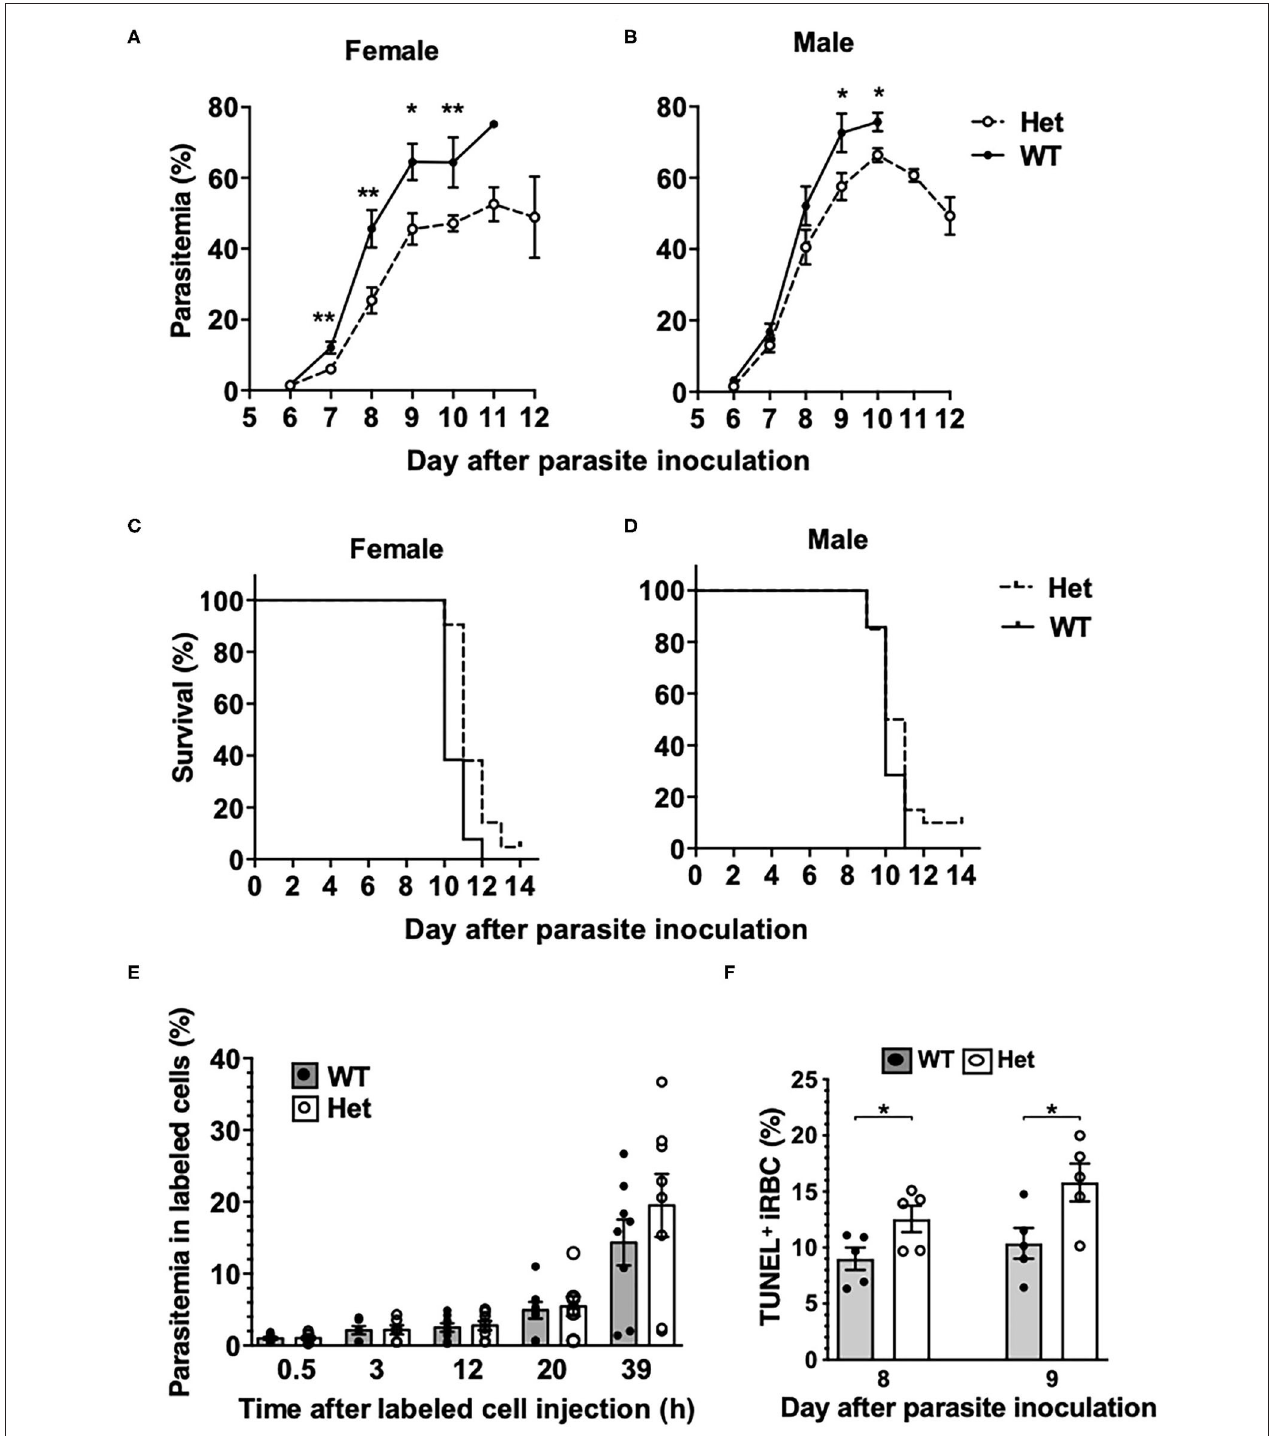
FIGURE 2 | Mice with the Pbgd MRI 58155 mutation display an increased resistance to infection with P. chabaudi . (A,B) Parasite growth and (C,D) survival in Pbgd MRI 58155 heterozygotes (Het) and wild-type littermates (WT) infected with P. chabaudi (1 × 10 4 parasites; 13–21 mice per group). (E) Parasitemia measured at various timepoints in labeled donor RBC following transfusion into P. chabaudi infected recipient mice (8 days after parasite inoculation). Donor RBC were from Pbgd MRI 58155 heterozygotes (Het) or wild-type littermates (WT) (8 recipient mice per group). (F) Proportions of TUNEL-labeled parasite-infected erythrocytes in Pbgd MRI 58155 heterozygotes (Het) or wild-type littermates (WT) infected with P. chabaudi (five per group). Error bars represent SEM. * p < 0.05, ** p < 0.01, calculated using a two-tailed t -test assuming equal variance. Log-rank (Mantel-Cox test) for differences in survival yielded p = 0.0016 (female group) and p = 0.16 (male).